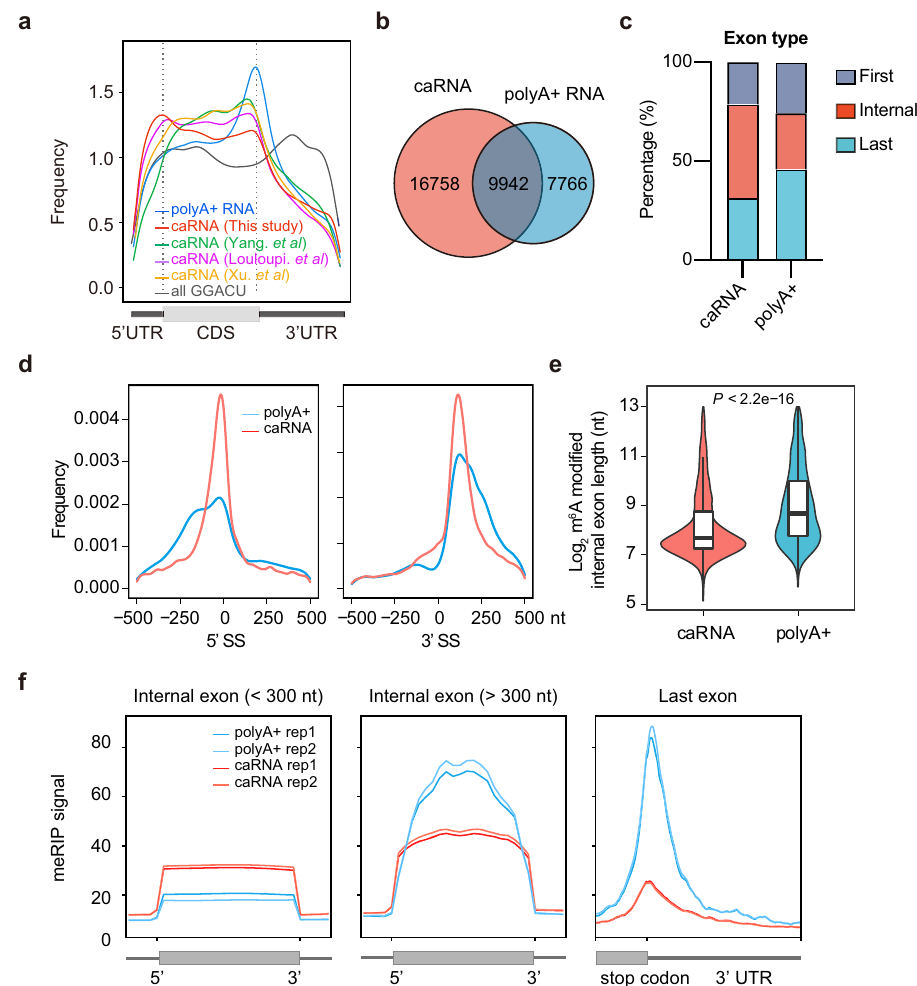
Fig.1|Nascenttranscriptscontainmorem 6 Ainshortinternalexonscompared with mature mRNAs. a Metaplot of meRIP-Seq showing the m 6 A distribution in polyA+ RNAs compared with chromatin-associated RNAs (caRNAs). Also shown is the distribution of the GGACU sequence motif. b Venn diagram showing the overlapofm 6 Apeaksidenti fi edinpolyA+RNAsandcaRNAs. c Barplotshowingthe percentageofm 6 Apeakswithinthe fi rst,internal,andlastexonsofprotein-coding